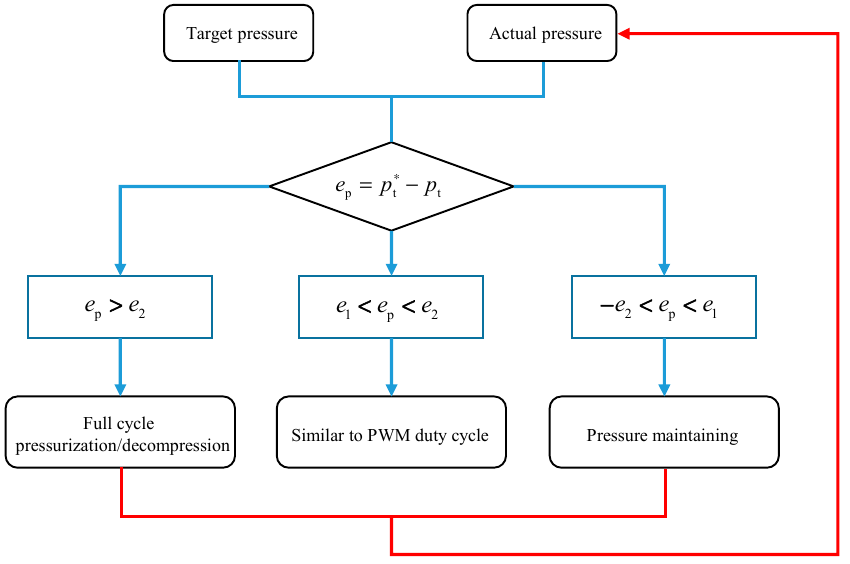
Figure 8. Logic block diagram of the segmented air pressure controller.